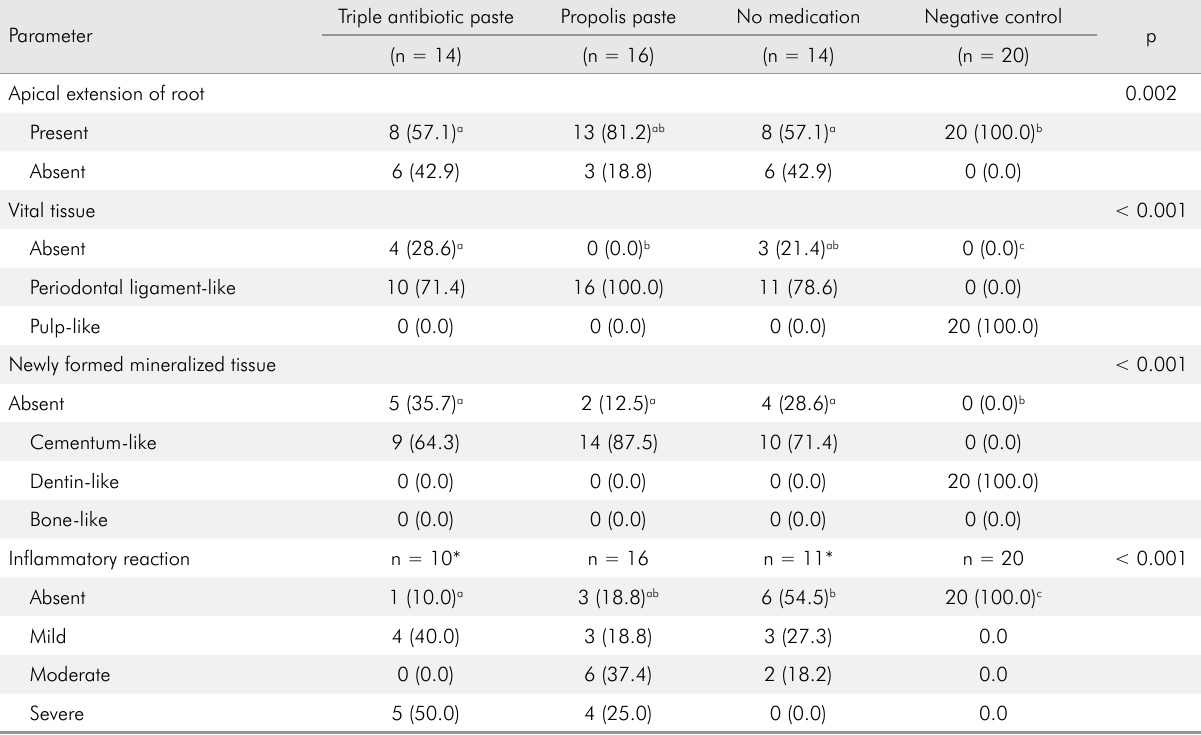
Table. Results obtained in the different groups.